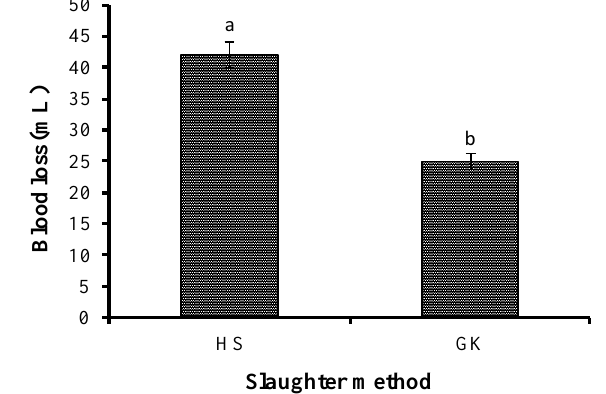
Figure 1. Differences in blood loss of New Zealand white rabbits subjected to halal slaughter without stunning and gas stun-killing. HS: Halal slaughter without stunning; GK: gas stun-killing. ab Means with different letters differ significantly at